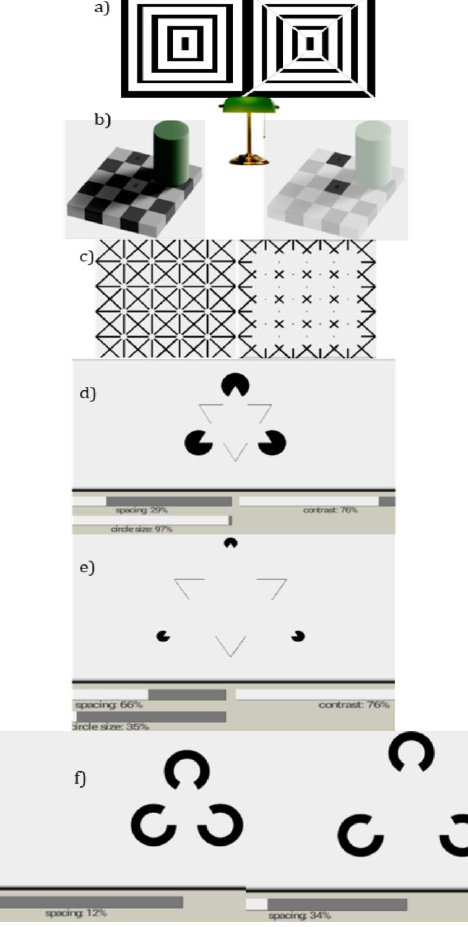
Figure 10. Serious game assessing the conservation of the perception of visual illusions in diabetic retinitis. ( a ) on the left, Kanizsa pyramid seems to come toward the observer and on the right, it seems to escape the observer; ( b ) exchequer illusion: the threshold value of the gray level of the umbra is chosen as that for which the observer perceives a gap between the gray levels of the squares A and B; ( c – f ) Kanizsa illusions with different geometric objects (circles on (c)) and triangles on (d–f)), the threshold value of the distance between them being the vanishing of their perception.